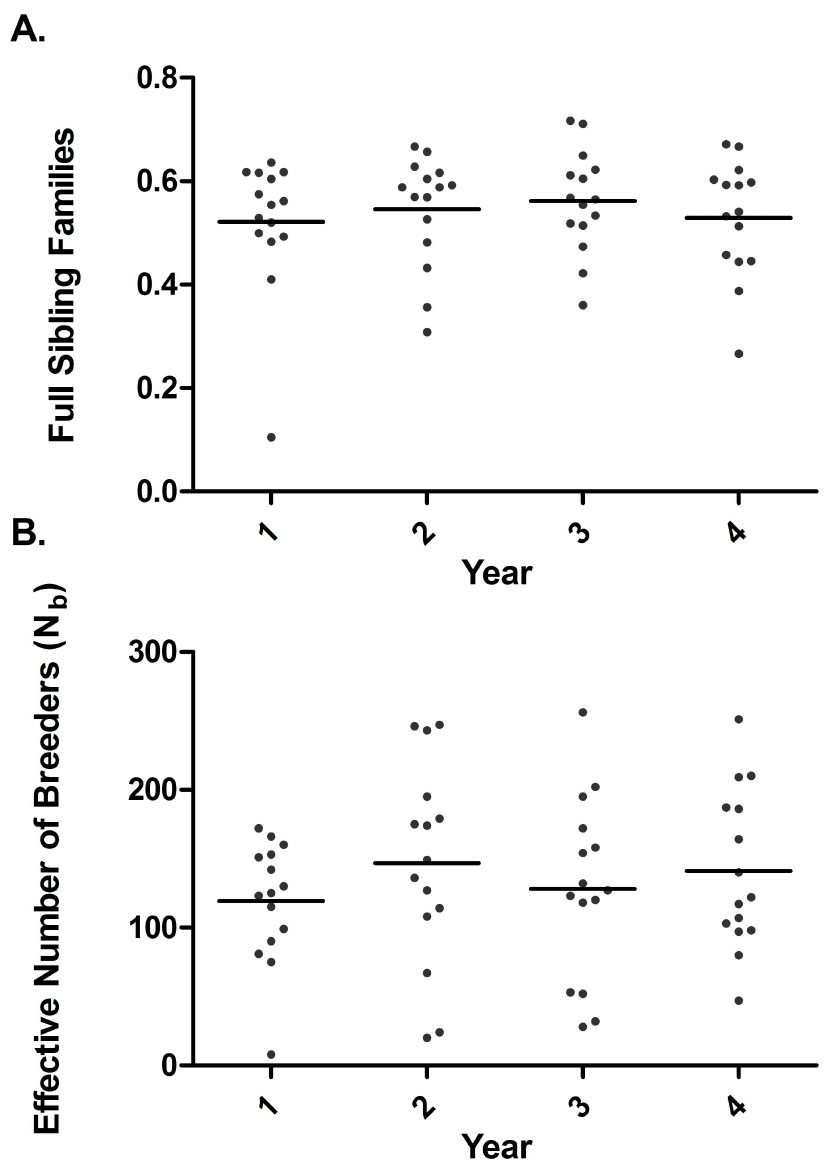
Figure 2. Mean changes in genetic estimators of schistosome worm burdens collected from humans during four years of an annual mass treatment program. Lines indicate means. A. number of full sibling families standardized according to sample size. B. effective number of breeders as estimated using the sibling assignment method.